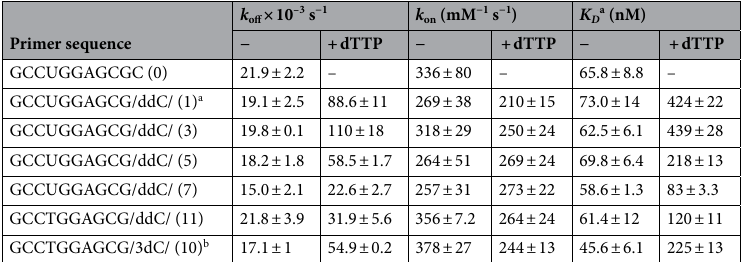
Table 2. Effect of primer structure and dTTP/Mg 2+ on interaction of human Polε CD with template:primer. 2 ′ -Deoxy- and 2 ′ ,3 ′ -dideoxy- nucleotides are underlined and their quantity is indicated in parenthesis. The provided values for DNA primers at 0.1 M NaCl are from Table 1. Data are presented as mean ± SD (n = 3). a / ddC/—2 ′ ,3 ′ -dideoxy-cytosine. b /3dC/—3 ′ -deoxy-cytosine.